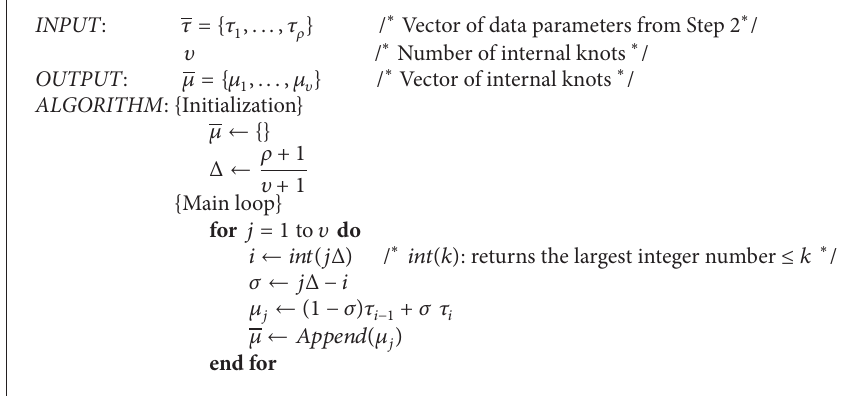
Algorithm 1: De Boor’s knot vector refinement